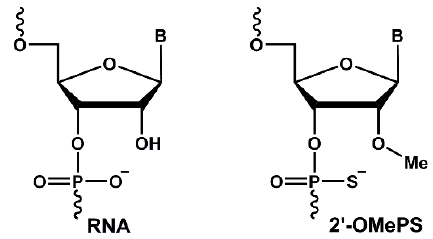
Figure 1. Structural representation of a 2’-O-methyl phosphorothioate (2’-OMePS) RNA